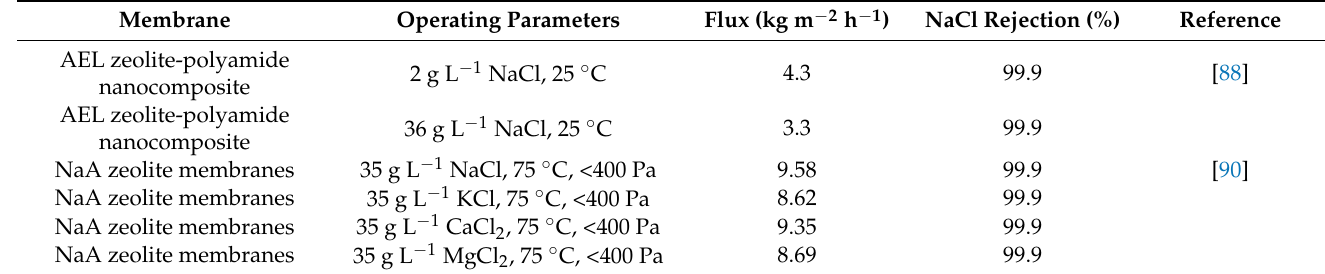
Table 4. Zeolite membranes studied for pervaporative desalination.